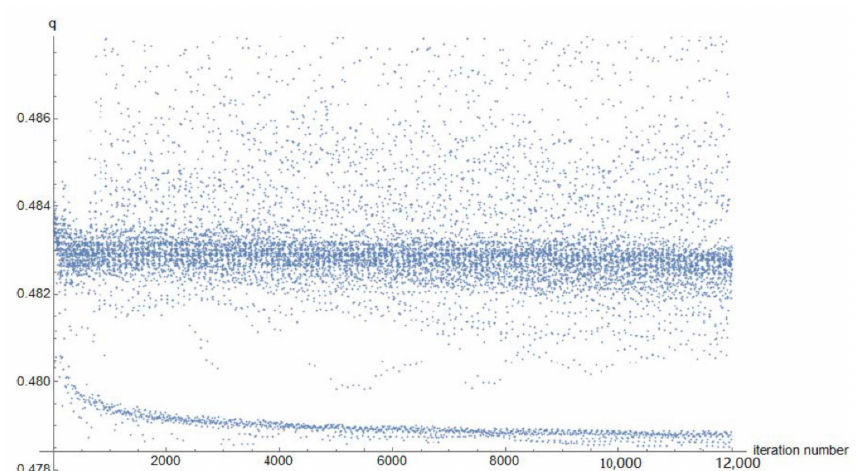
Figure 8. The results of the estimation of the imitation coefficient ( q ) for Austria in successive iterations of the nonlinear least squares method [own study].